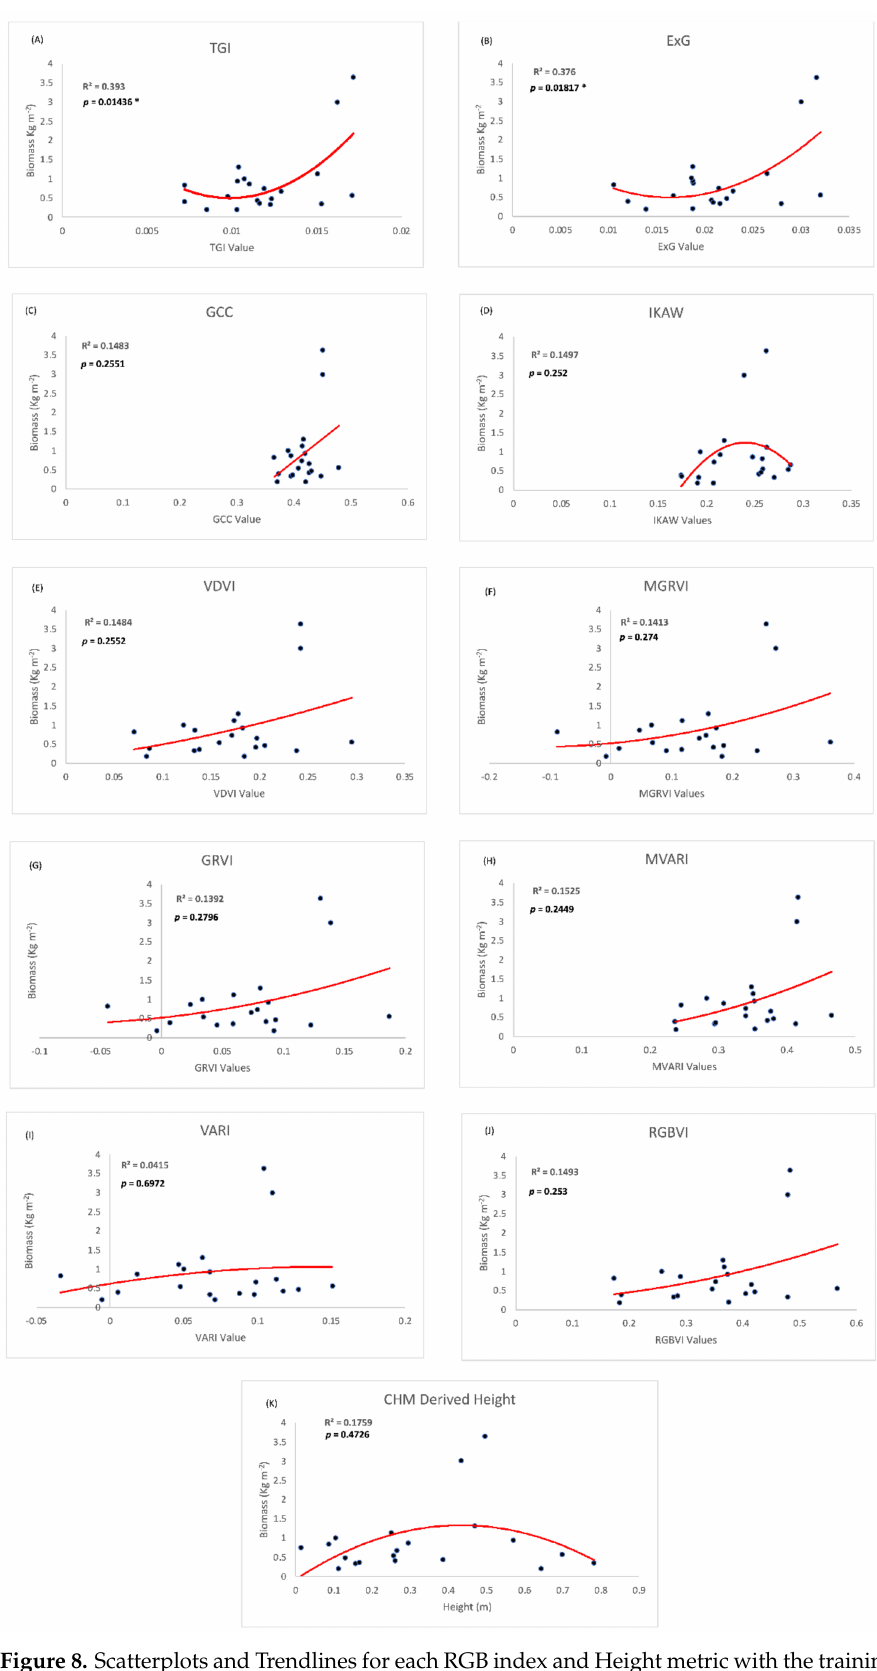
Figure 8. Scatterplots and Trendlines for each RGB index and Height metric with the training biomass data. R 2 represents the coefficient of determination, and p values are indicated if the model was significant. Asterisks (*) indicate statistically significant models at